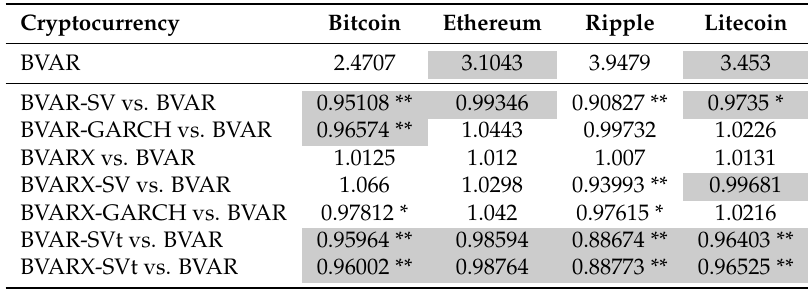
Table 5. Ratio of CRPS against